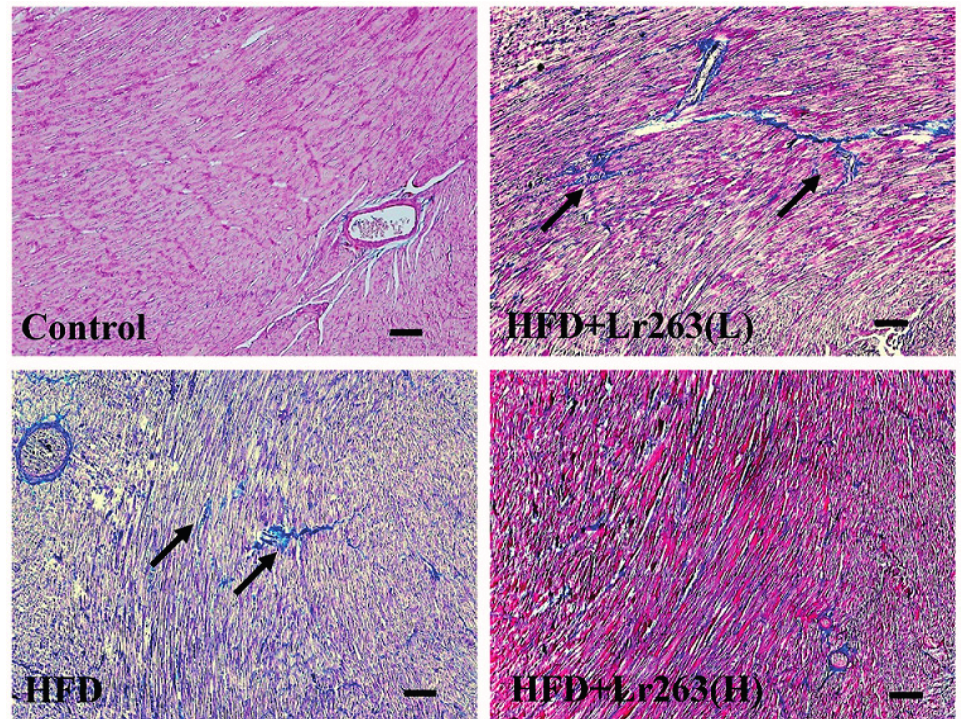
Figure 5. Assessment of fibrosis in the animal hearts. Cirrhosis was assessed using Masson’s trichrome (MS) staining assay to indicate collagen accumulation (the blue color indicated by the arrows) in the heart tissue slides. The bar length is 100 μ